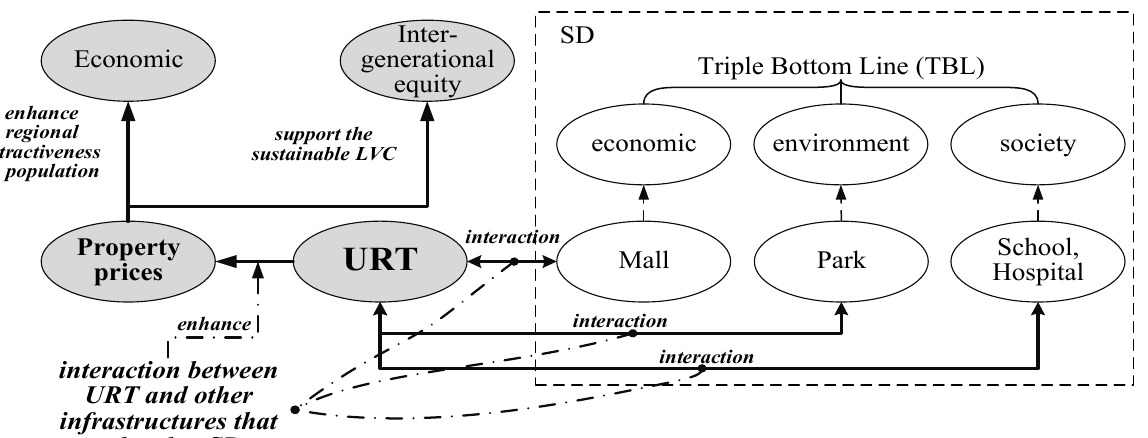
Figure 1. The effects of URT and neighborhood infrastructures on property prices from perspective of sustainable development.